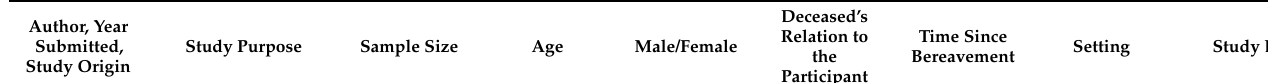
Table A3. Summary of grey